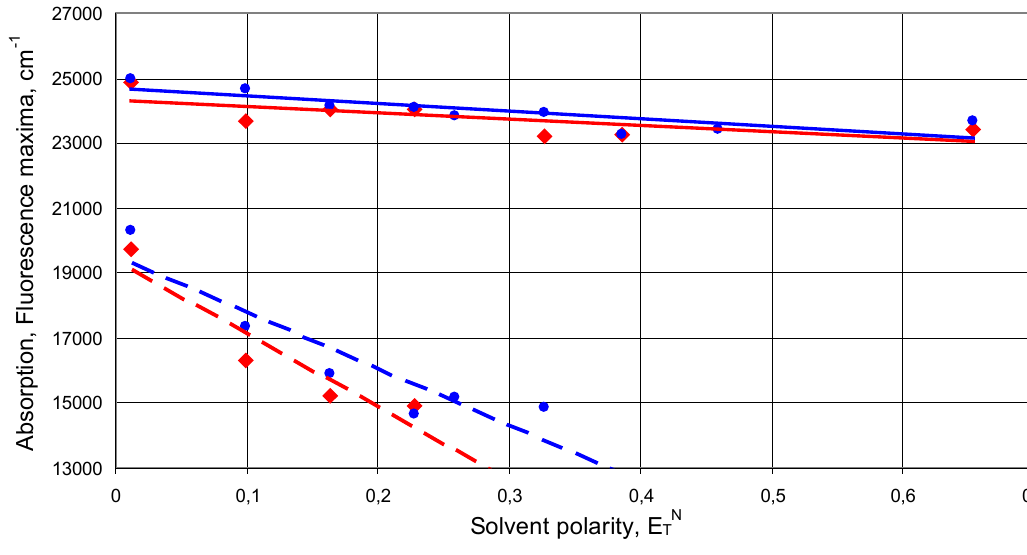
Figure 2. Solvatochromic behavior of compounds I (red lines: solid - absorption, dashed - fluorescence) and III (blue lines) presented versus the Reichardt solvent polarity function E TN